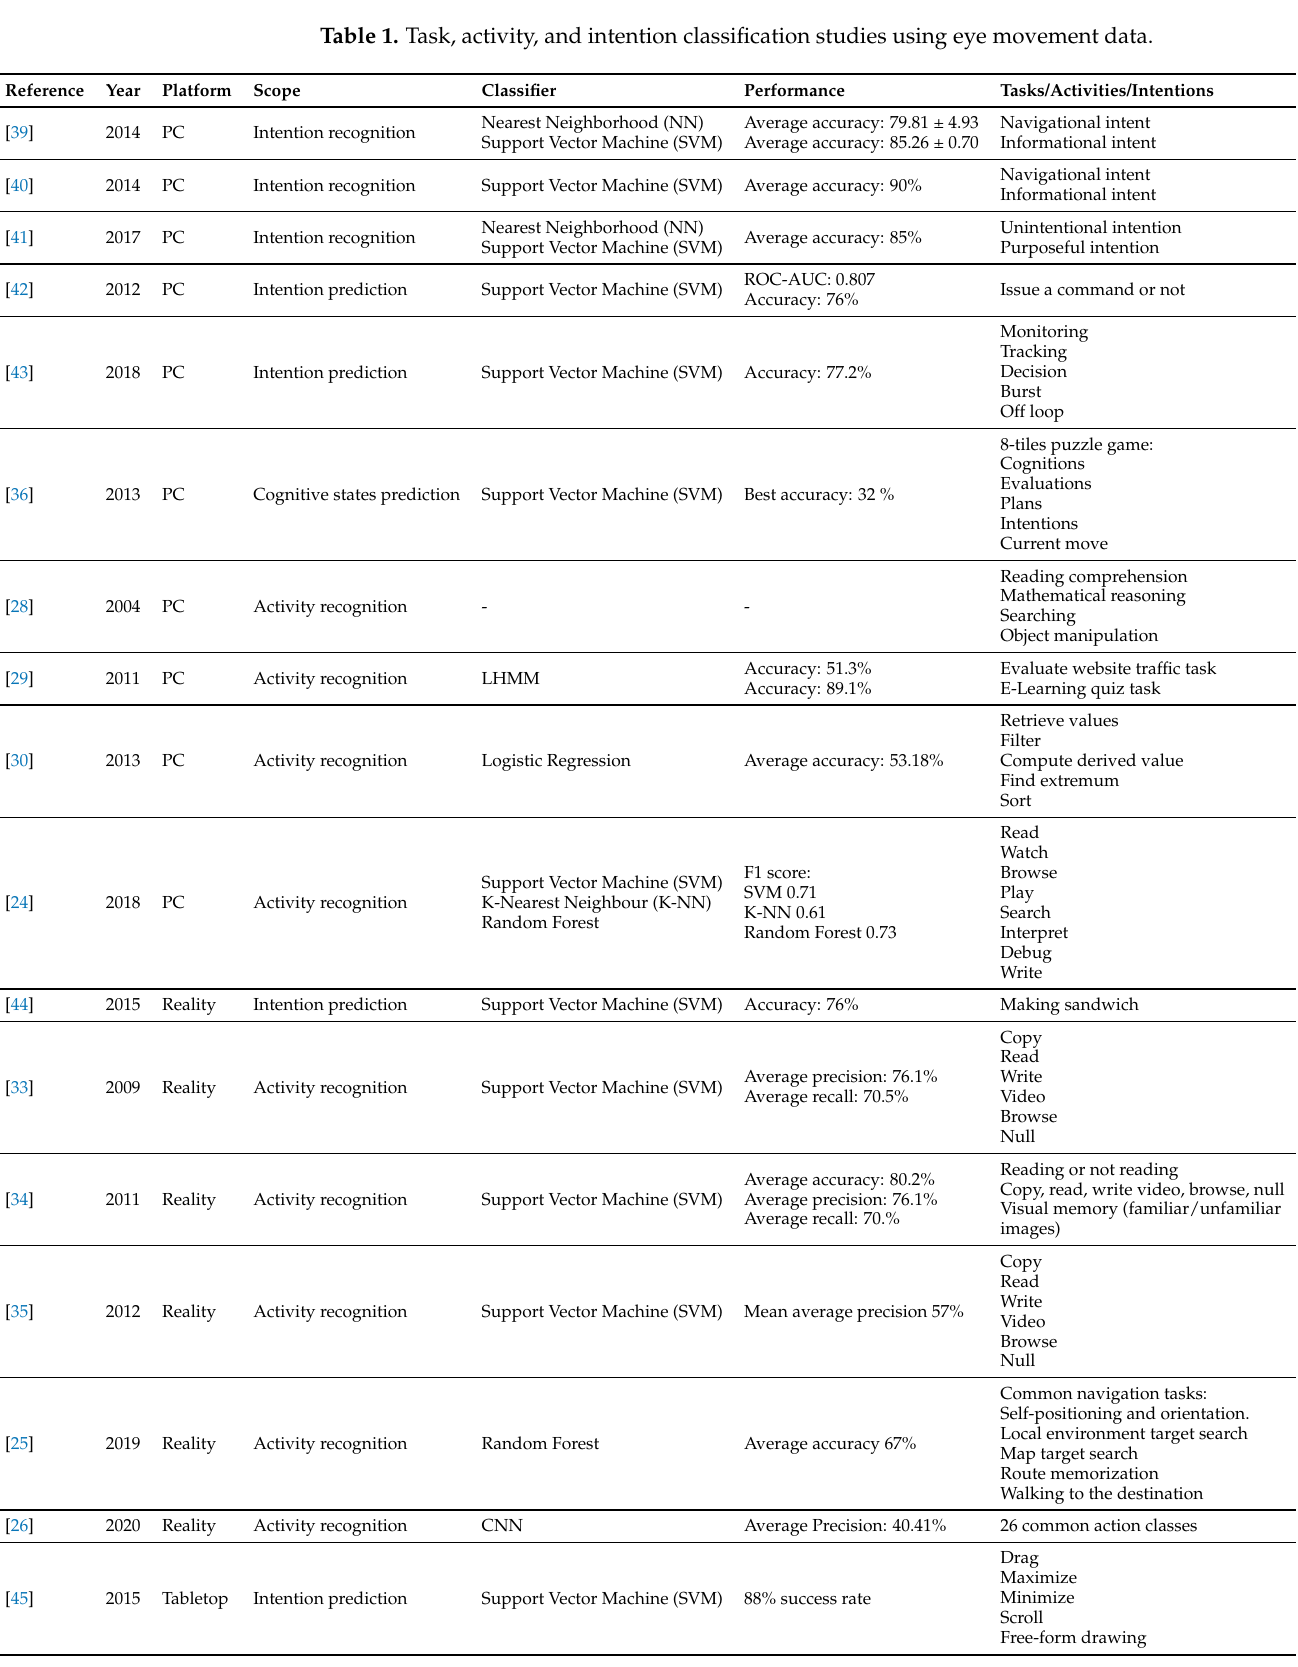
Table 1. Task, activity, and intention classification studies using eye movement